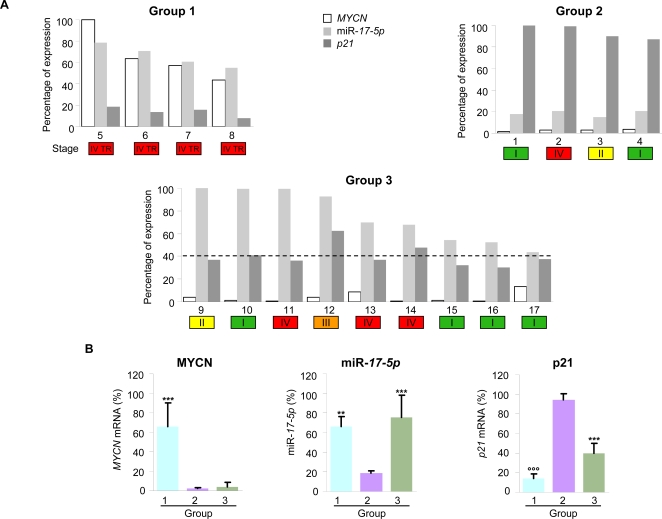
miR-17-5p expression is correlated to MYCN and p21 levels in human primary neuroblastomas.(A) Expression of MYCN, miR-17-5p and p21 was analyzed in primary tumors by qRT-PCR. Depending on the expression levels of MYCN and miR-17-5p, primary tumors were divided into three groups. Group 1 (left upper panel) includes MYCN-amplified tumors displaying high levels of miR-17-5p and very low levels of p21. Group 2 (right upper panel) includes MYCN-not-amplified tumors expressing low levels of miR-17-5p and high levels of p21. Group 3 (lower panel) includes MYCN-not-amplified tumors expressing high levels of miR-17-5p and moderately low levels of p21 (a 40% decrease baseline is shown). The coloured boxes indicate the tumor stage (from I to IV) and the therapy resistant tumors (TR). (B) Expression of MYCN, miR-17-5p and p21 in the three groups of primary tumors. Mean±s.d.. ** P<0.01, *** P<0.001 when compared to second group; °°° P<0.001 when compared to the other groups.